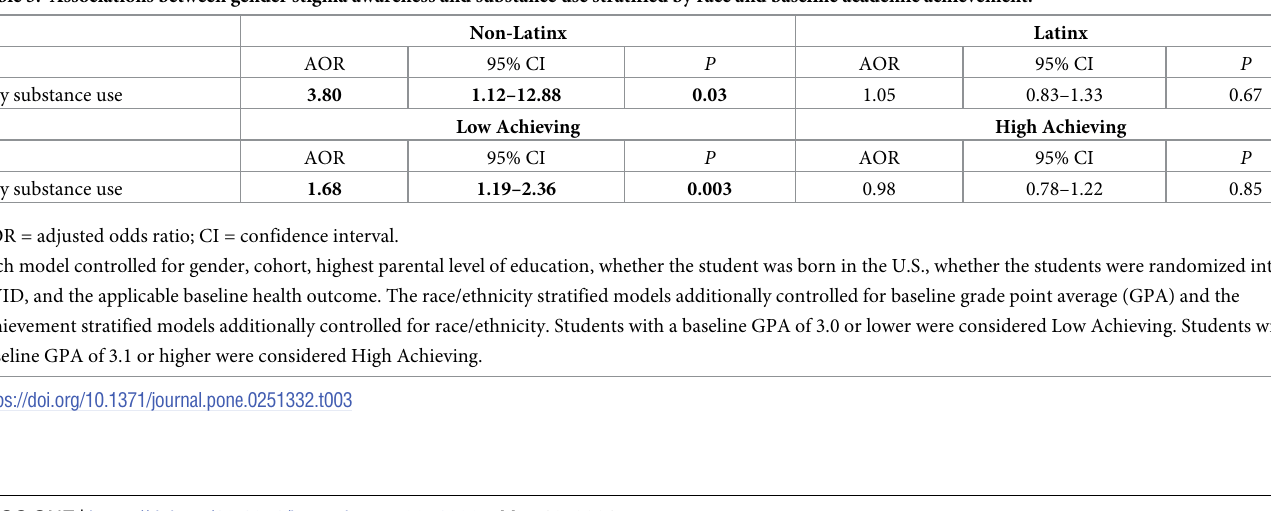
Table 3. Associations between gender stigma awareness and substance use stratified by race and baseline academic